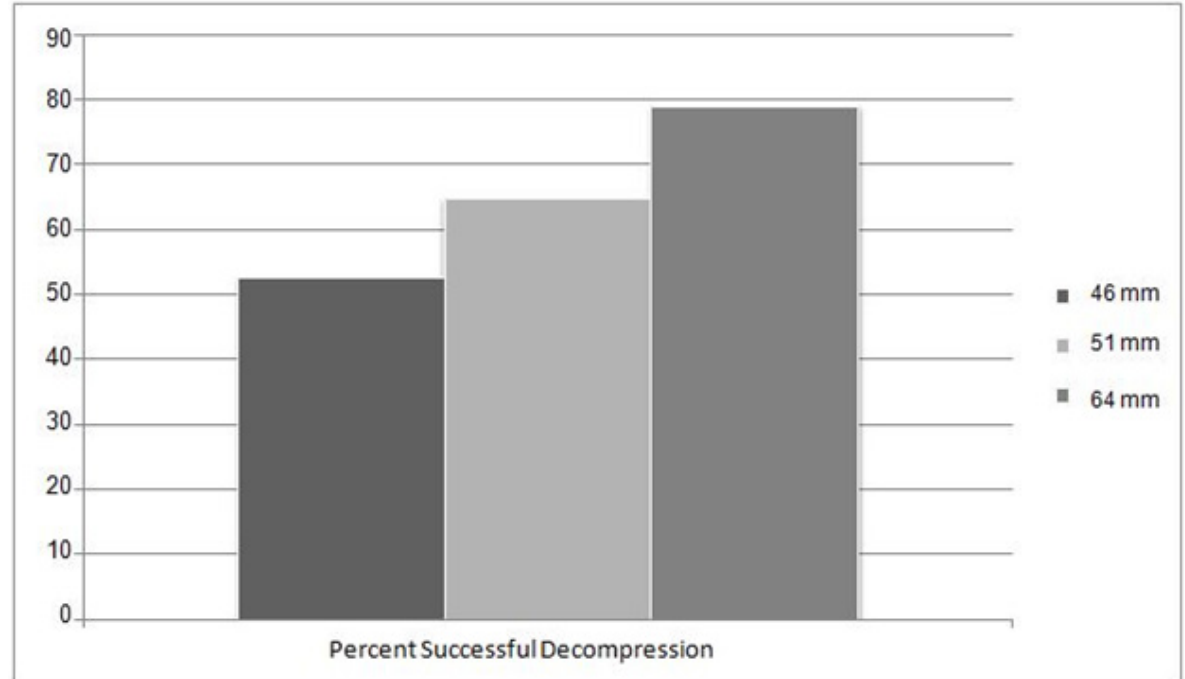
Figure . Depicts the success rates with different lengths of needles used for decompression of tension